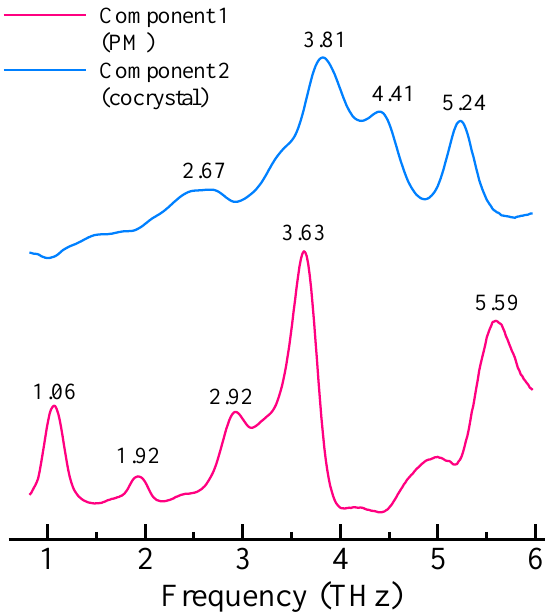
Figure 6. Calculated THz spectra of the PM (red, component 1) and cocrystal (blue, component 2) obtained by MCR-ALS analysis. The spectra were deconvoluted into two components.